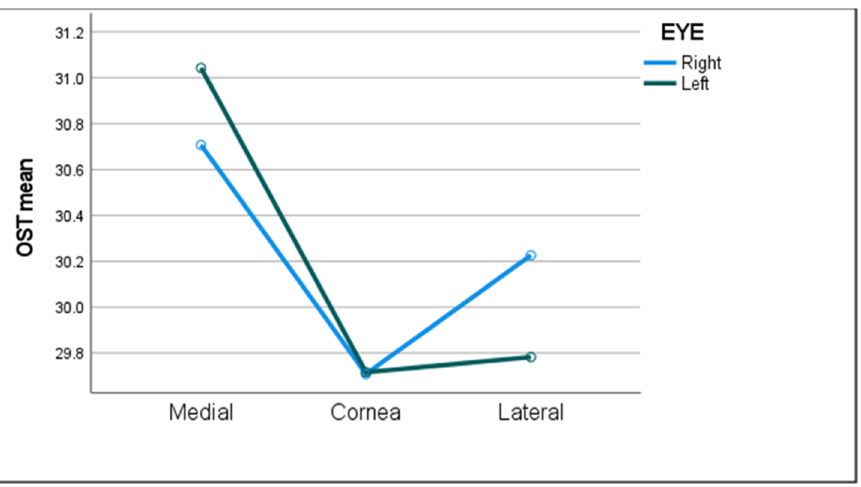
Figure 2. The mean ocular surface temperature (OST) in all three ocular surface regions of both eyes. The univariate analysis yielded a significant sex difference in OST in the central cornea, with values 0.5 °C higher in males ( p = 0.01). OST was also significantly higher in all three regions in the eyes of subjects who had a history of ischemic heart disease (IHD) ( p < 0.03 for each). There was no significant OST difference associated with hypertension, diabetes mellitus, active smoking status, or obstructive sleep apnea, nor with a pathologic result on the cardiac stress test (Table 3). Table 3. OST differences in the presence of cardiovascular risk factors and cardiovascular disease.